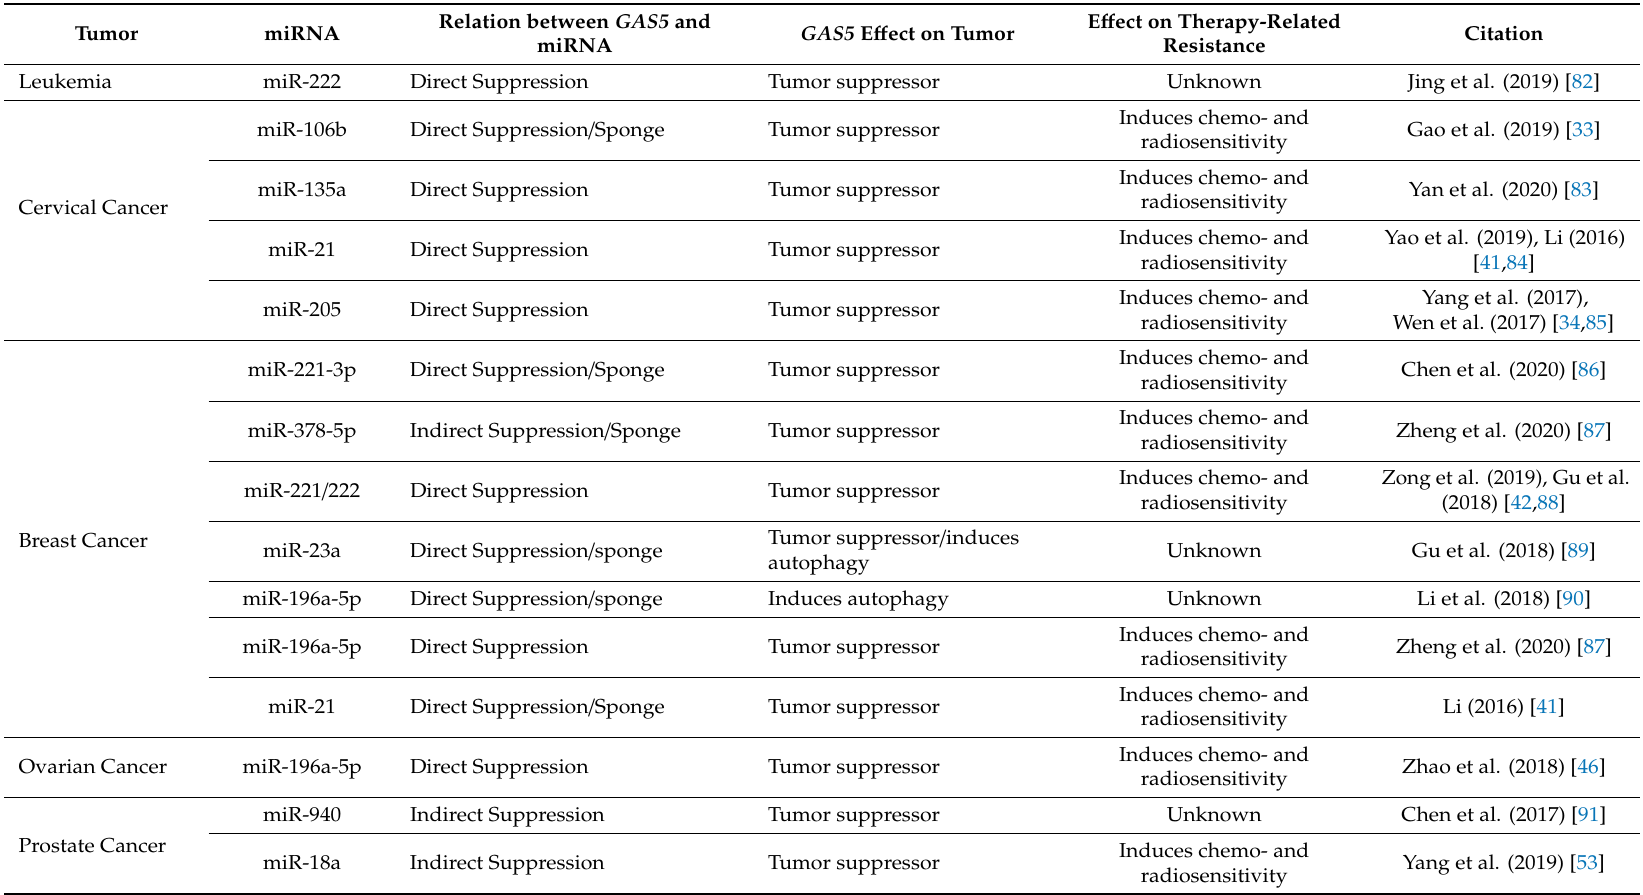
Table 1. Summary of the relation of GAS5 and miRNAs in several